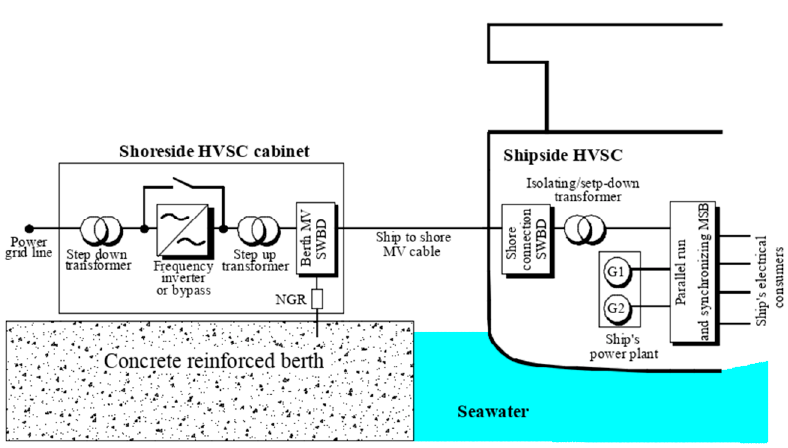
Figure 4. Scheme of a typical cold ironing system with a frequency converter.